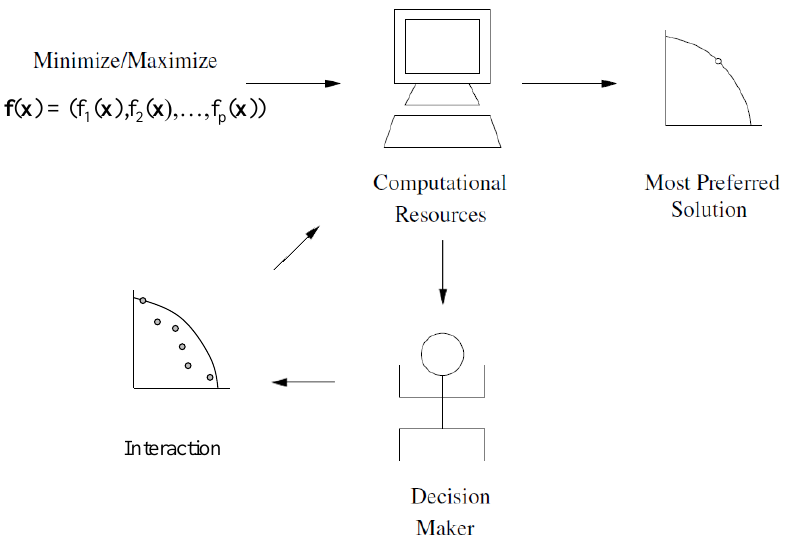
Figure 5. Interactive approach.